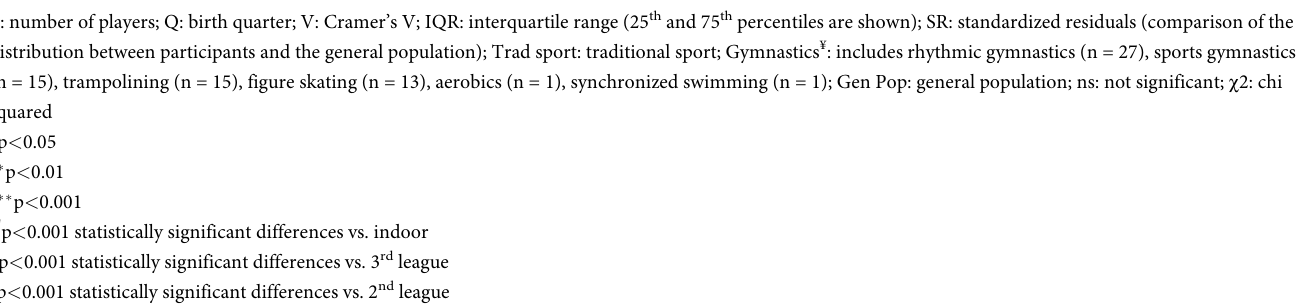
Table 5 for girls. Additionally, comparison of the median age between leagues and age groups of boys participating in football is shown in Table